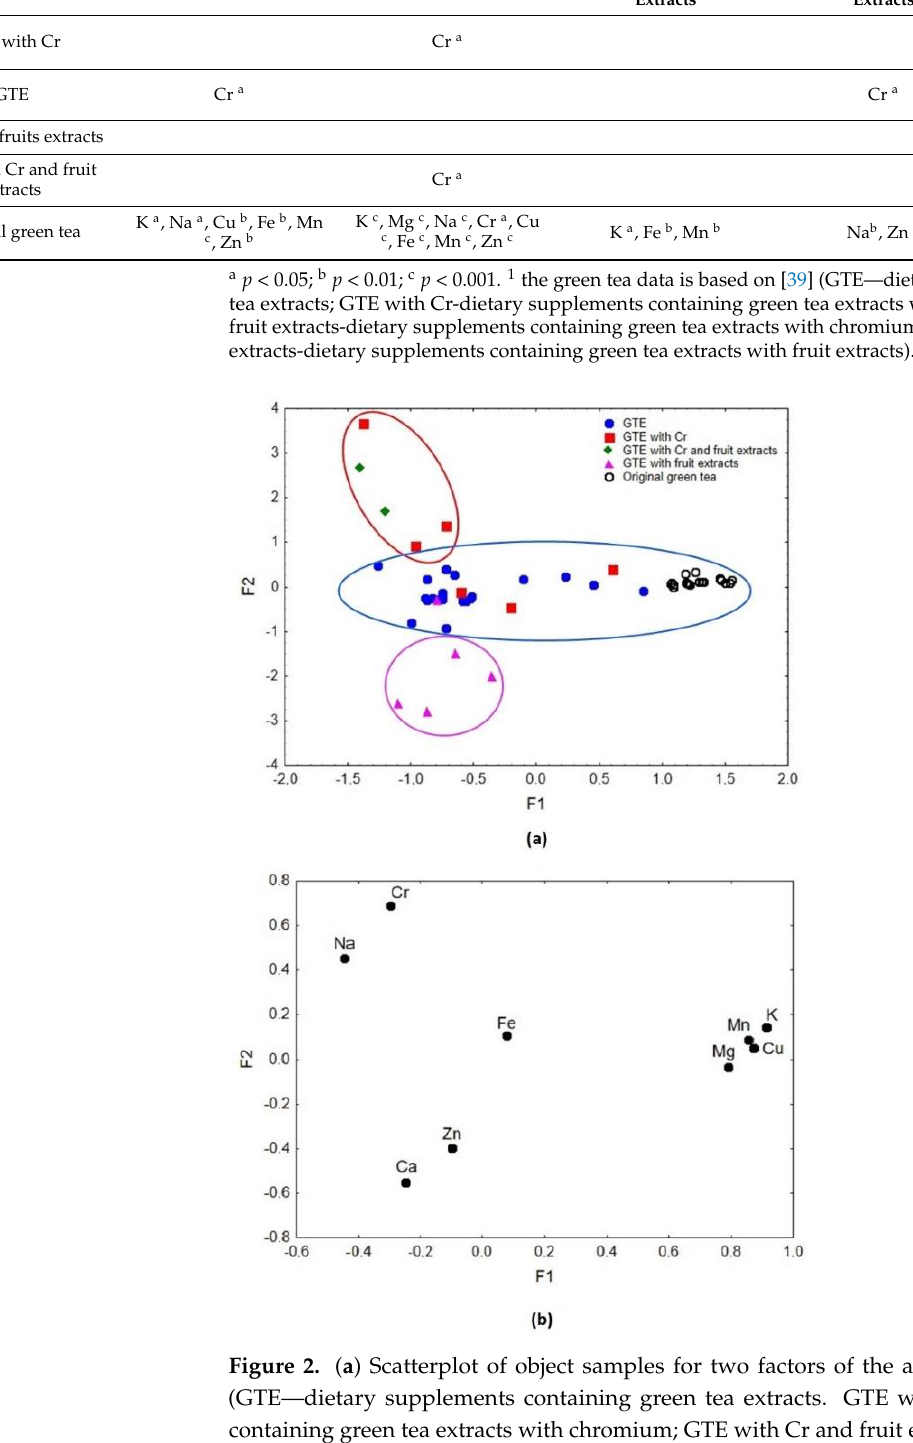
Figure 3. Hierarchical dendrogram for the analysed dietary supplements. GTE — dietary supple- ments containing green tea extracts; GTE with Cr — dietary supplements containing green tea ex- tracts with chromium; GTE with Cr and fruit extracts — dietary supplements containing green tea extracts with chromium and fruit extracts; GTE with fruit extracts — dietary supplements containing green tea extracts with fruit extracts) and green tea samples. The data concerning green tea are based on Brzezicha-Cirocka et al. [39].